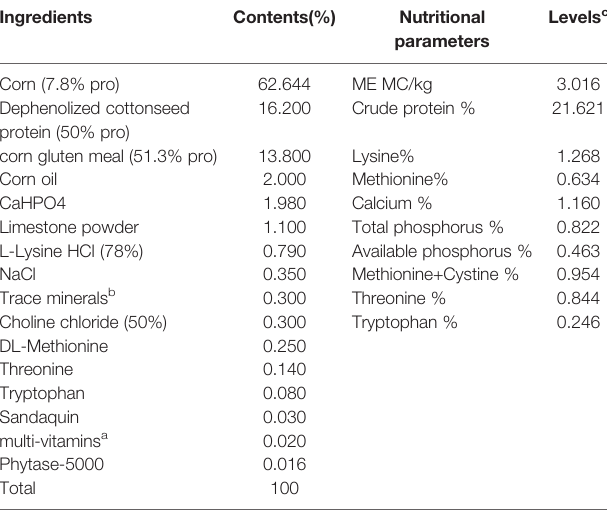
TABLE 1 | Test diet composition and nutrition level (air-dry